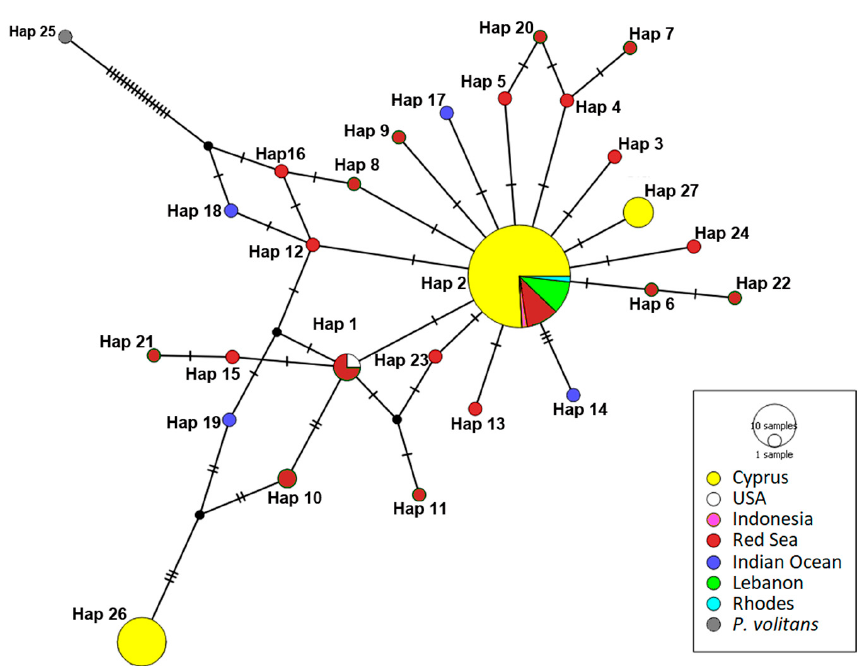
Figure 3. Median-joining haplotype network for CR sequences. Different colors correspond to geographic origin and circle size is proportional to the number of individuals with the same haplotype. Hatch marks along edges represent the number of mutations between nodes. Accession numbers for individuals representing each haplotype are given in Table S2.